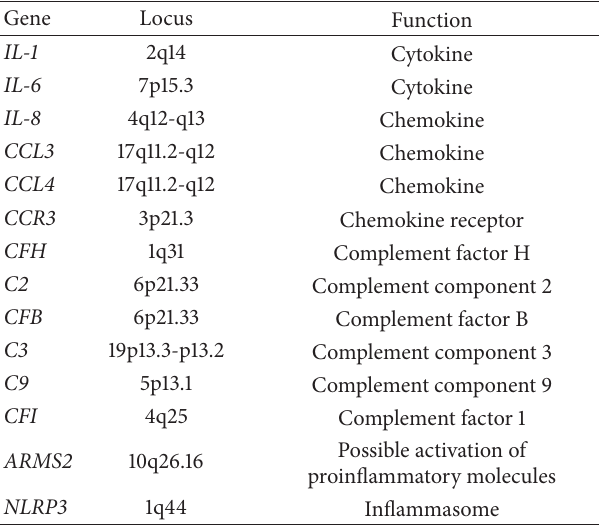
Table 2: AMD genes involved in the inflammatory